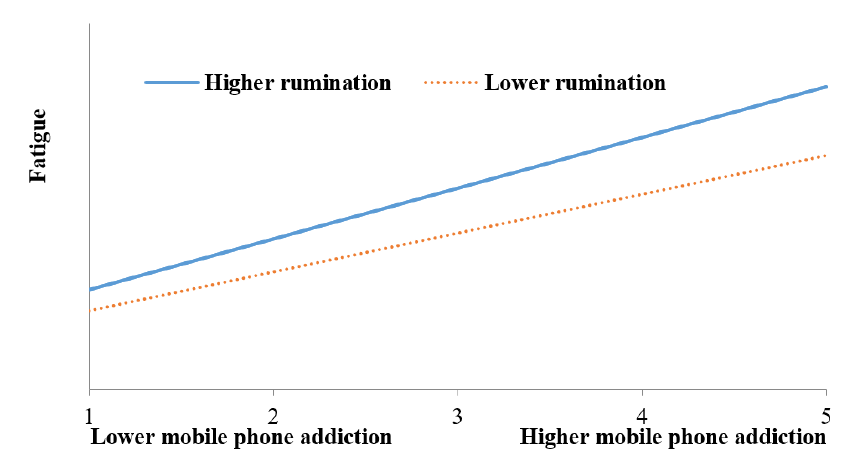
Figure 2. Rumination moderates the relationship between mobile phone addiction and fatigue.